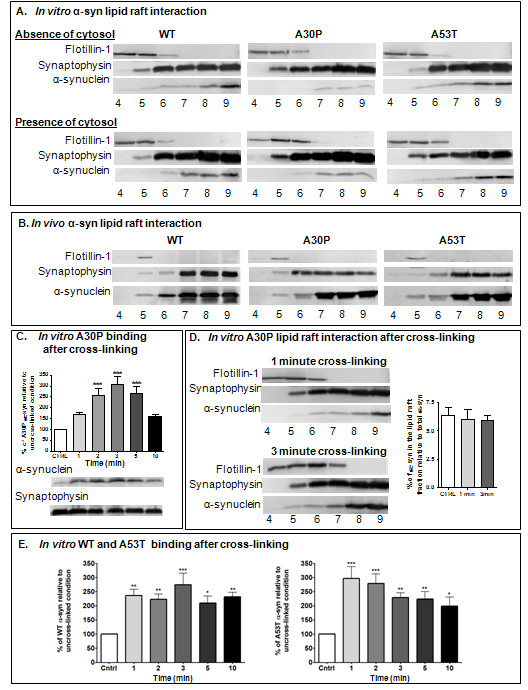
α-Syn binding to synaptosomal lipid rafts. Using a 42-30-5% discontinuous sucrose gradient, we analysed the proportion of α-syn that co-localised with flotilin-1, a lipid-raft marker. (A) Less then 5% of α-syn co-eluted with flotillin-1 after binding (in vitro) to α-syn KO synaptic membranes, in absence or presence of KO cytosol, and proportionally, no significant differences were observed between Wt and PD-linked mutants (Student's T-test, p > 0.05). (B) The proportion of α-syn that co-localised with flotillin-1 in vivo, using intact synaptosomes from transgenic mice expressing the human α-syn (Wt, A30P or A53T). As observed in vitro, only a small proportion of α-syn co-eluted with lipid rafts and no significant differences were observed between Wt and PD-linked mutations (Student T-test, p > 0.05). (C) A30P α-syn was subjected to paraformaldehyde-induced cross-linking to potential interacting proteins in synaptic membranes after 1, 2, 3, 5 and 10 minutes of incubation with synaptic membranes. A significant increase of bound α-syn after 2, 3 and 5 minutes was observed compared to the control condition (without cross-linking) (One-Way ANOVA p < 0.001, Bonferroni's multiple comparison test). (D) The proportion of α-syn present in the lipid-raft fraction after cross-linking did not show any significant differences compared to incubations without cross-linking (Student t-test: 1 min: p > 0.05; 3 min: p > 0.05). (E) A significant increase of bound Wt and A53T α-syn after paraformaldehyde-induced cross-linking was observed compared to the control condition without cross-linking (One-Way ANOVA, *p < 0.05, **p < 0.01,***p < 0.001, Bonferroni's multiple comparison test).